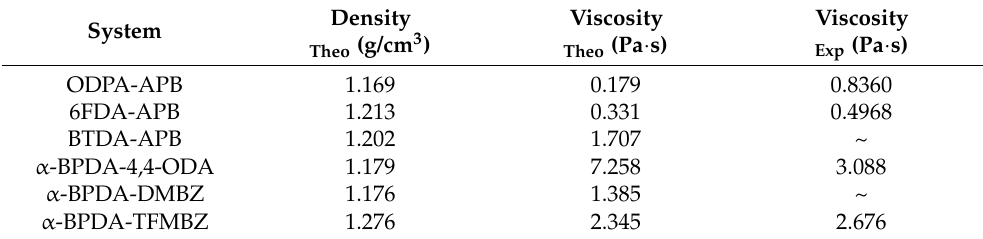
Table 1. The system density of the prepolymerized PI resins was calculated theoretically, and the prepolymer melt viscosity of the PI resins was measured experimentally and calculated theoretically at 573.15K.